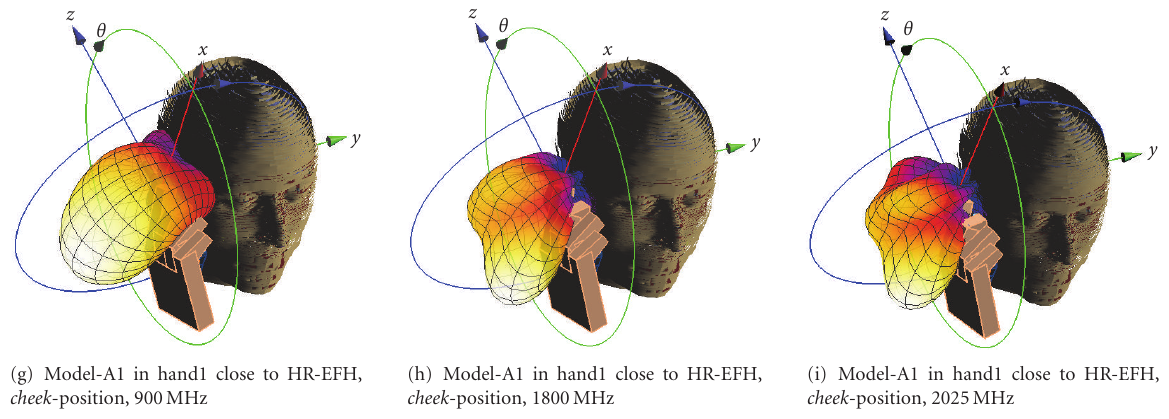
Figure 5: The three-dimensional far-field radiation patterns of the handset model-A1 in free space, in hand1 close to SAM and in hand1 close to HR-EFH at 900, 1800, and 2025